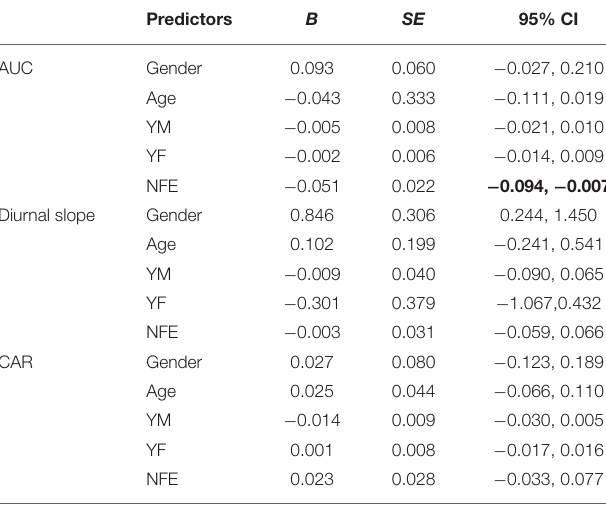
TABLE 2 | Linear regression for negative family expressiveness with AUC, diurnal slope and CAR.